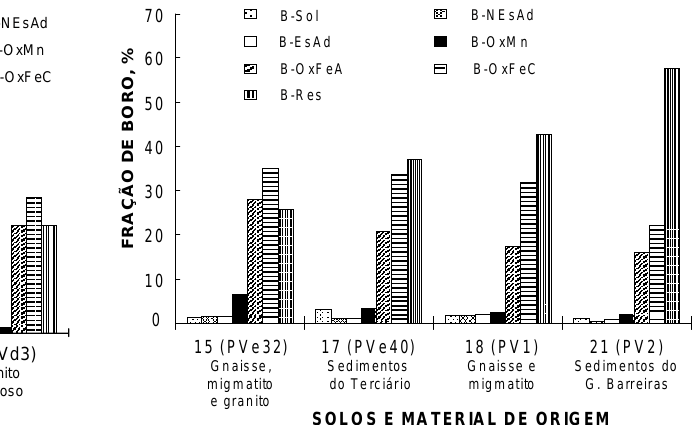
Figura 2. Distribuição percentual de quatro Podzólicos Vermelho-Amarelos de diferentes materiais de